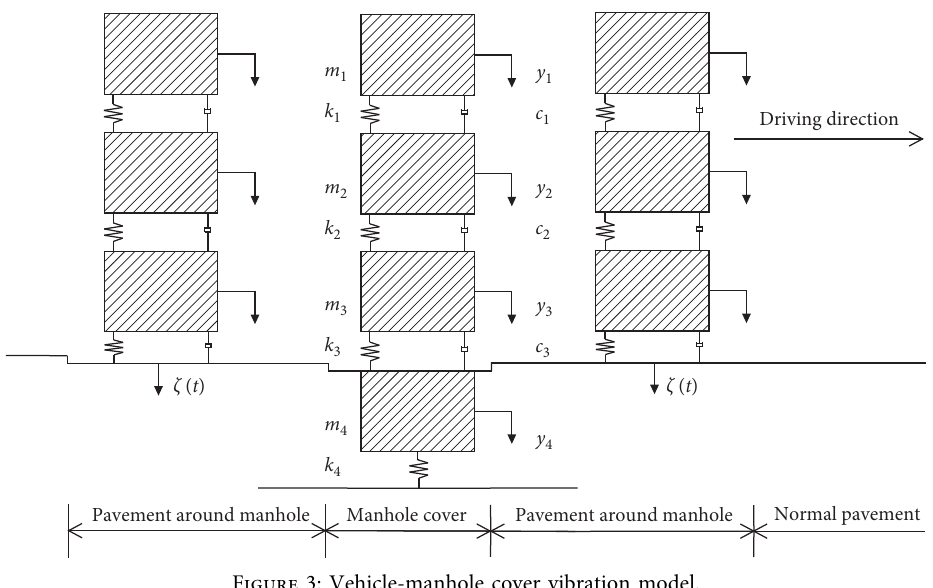
Figure 3: Vehicle-manhole cover vibration